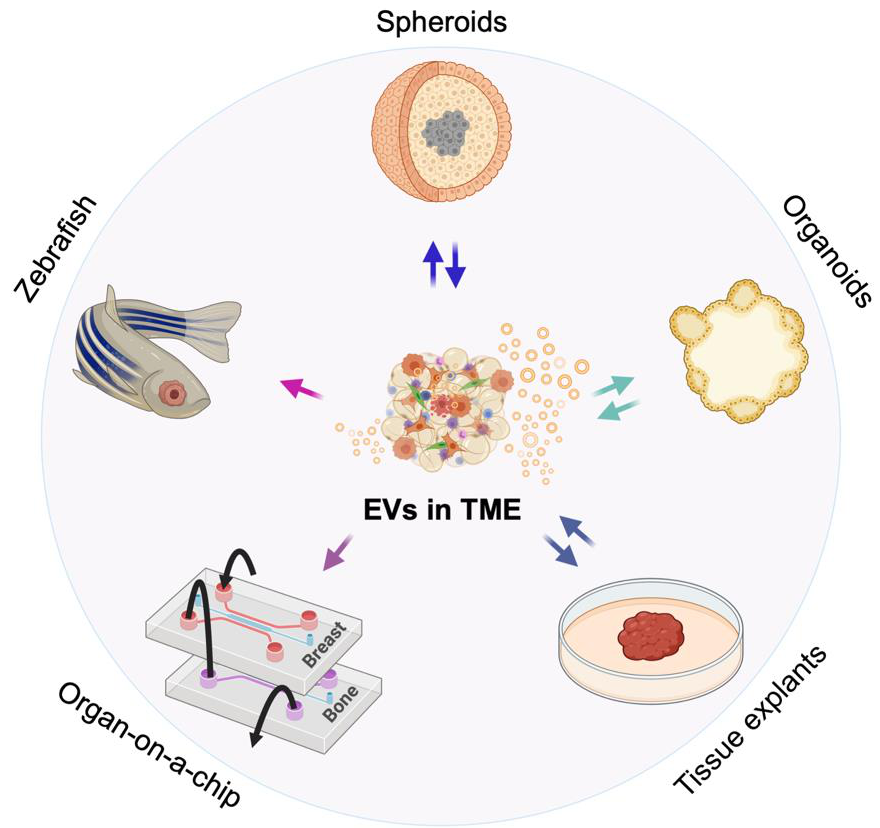
Figure 1. Schematic illustration of various methods to study extracellular vesicles (EVs) in the tumor microenvironment (TME) including spheroids, organoids, tumor explants, organ-on-a-chip and zebrafish. Created with BioRender.com (accessed on 3 April 2021).